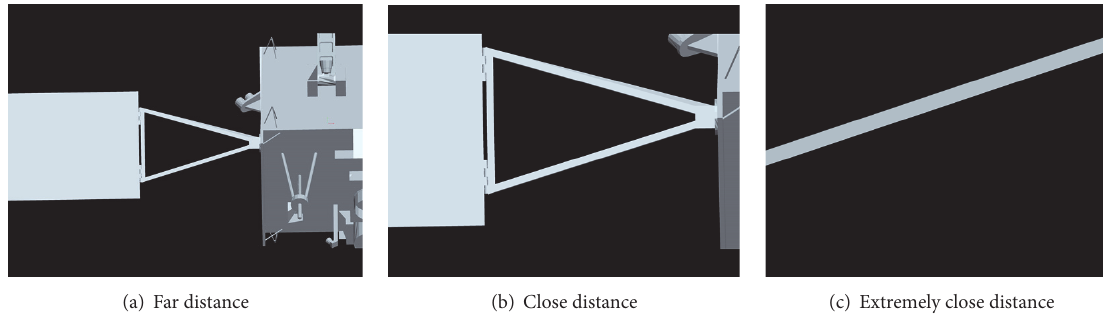
Figure 2: Images captured in different approaching